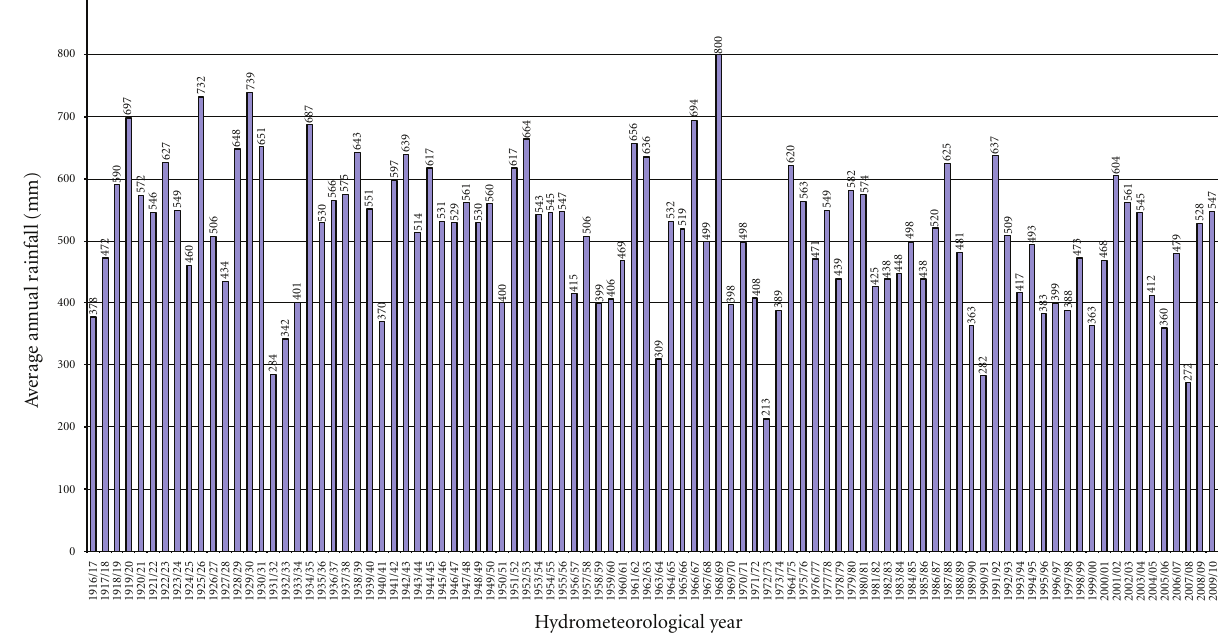
Figure 1: Time series of the annual area average precipitation in Cyprus (1917–2010).